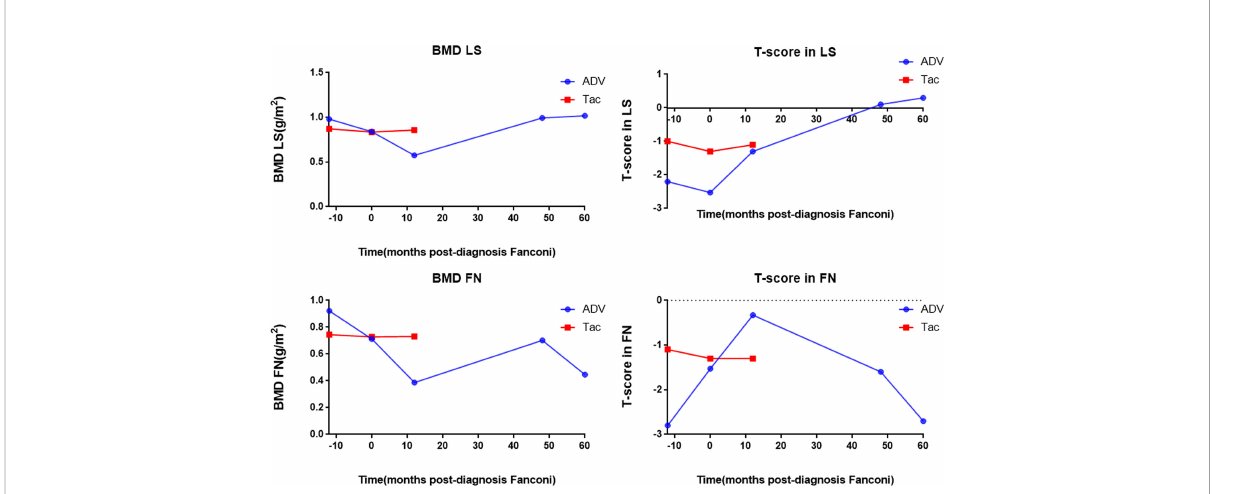
FIGURE 3 Bone mineral density and T-score of the patients. BMD LS, bone mineral density lumbar spine; T-score in LS, T-score in lumbar spine; BMD FN, bone mineral density femoral neck; T-score in FN; T-score in femoral neck, ADV, Adefovir dipivoxil; Tac,